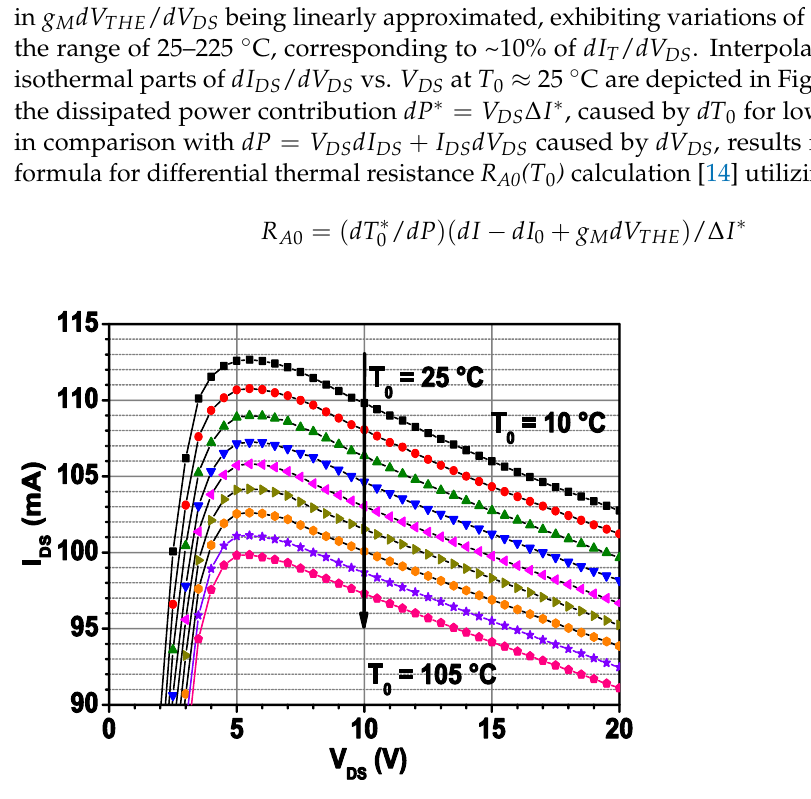
Figure 4. Transconductance g M , g M 0 and threshold voltage V TH and V THN dependence on V DS at var- ious T 0 required for trapping phenomena incorporation.